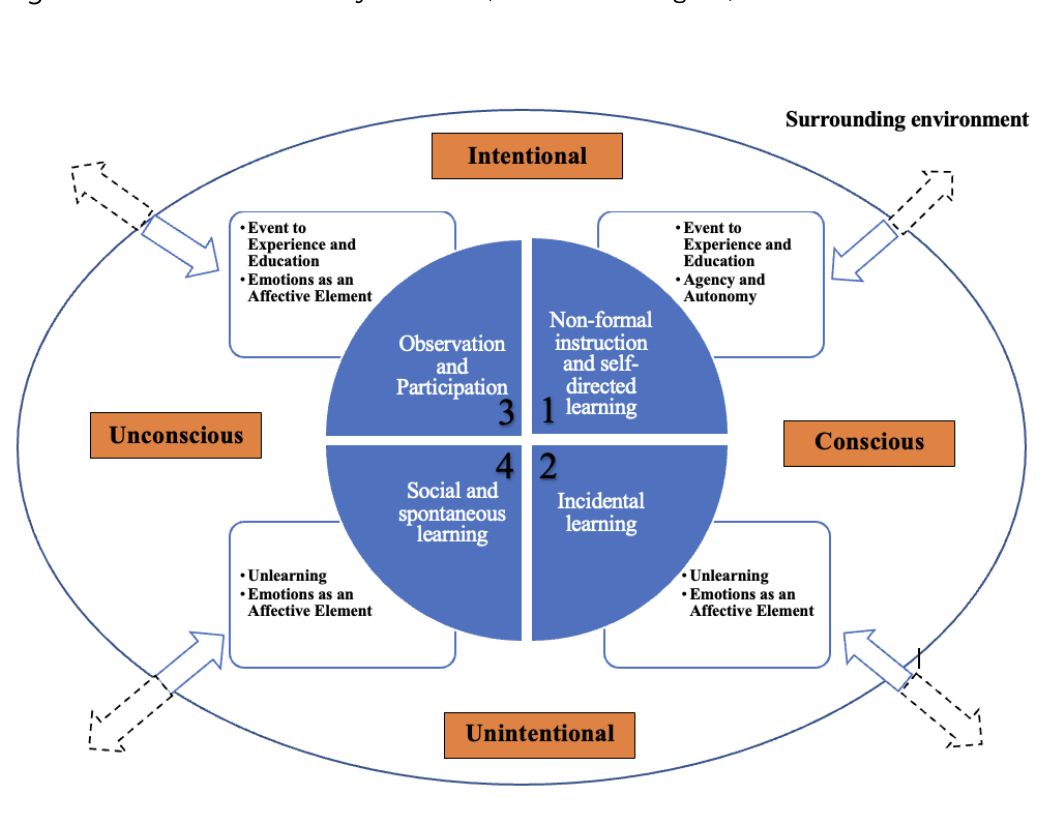
Figure 1. Elements of a theory of SML (authors’ own